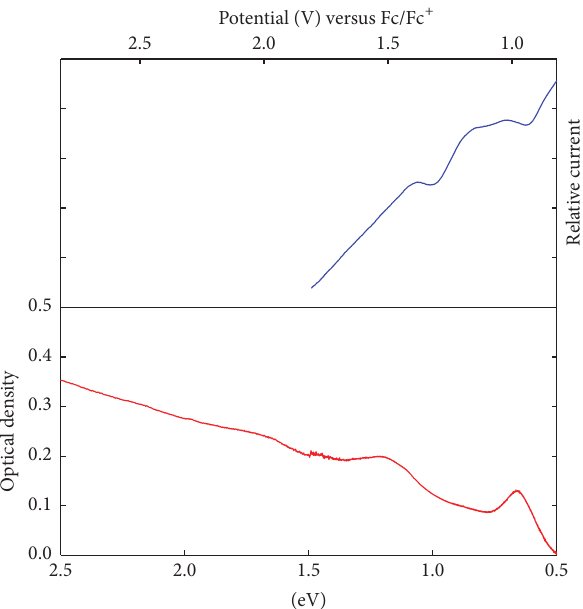
Figure 3: The comparison of DPV spectrum to UV-near infrared absorption of SWNTs. Up: DPV curve of THHP ⋅ SWNTs ; bottom: UV-near infrared absorption spectrum of THHP ⋅ SWNTs